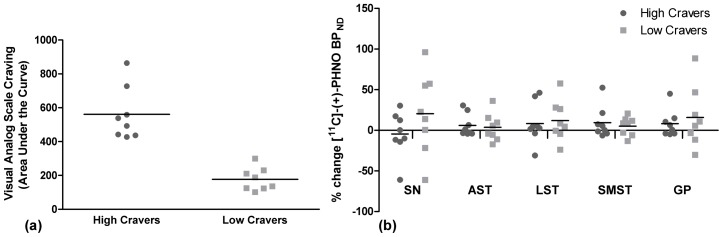
High cravers versus low cravers area under the visual analog scale curve and percent change in [11C]-(+)-PHNO BPND in regions of interest.(a) Area under the Visual Analog Scale curve in high cravers and low cravers. (b) Percent change in [11C]-(+)-PHNO BPND in the associative striatum (AST), limbic striatum (LST), sensorimotor striatum (SMST), globus pallidus (GP) and substantia nigra (SN) in high cravers versus low cravers. There were no significant differences in percent change in [11C]-(+)-PHNO BPND in any of the aprior regions of interest when comparing high cravers to low cravers (multivariate analysis of variance (MANOVA) F(5,10) = 0.759, p = 0.731).